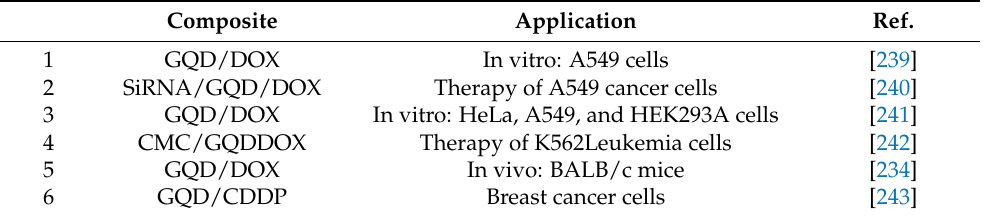
Table 2. The application of bioactive GQDs in the field of drug delivery. Composite Application